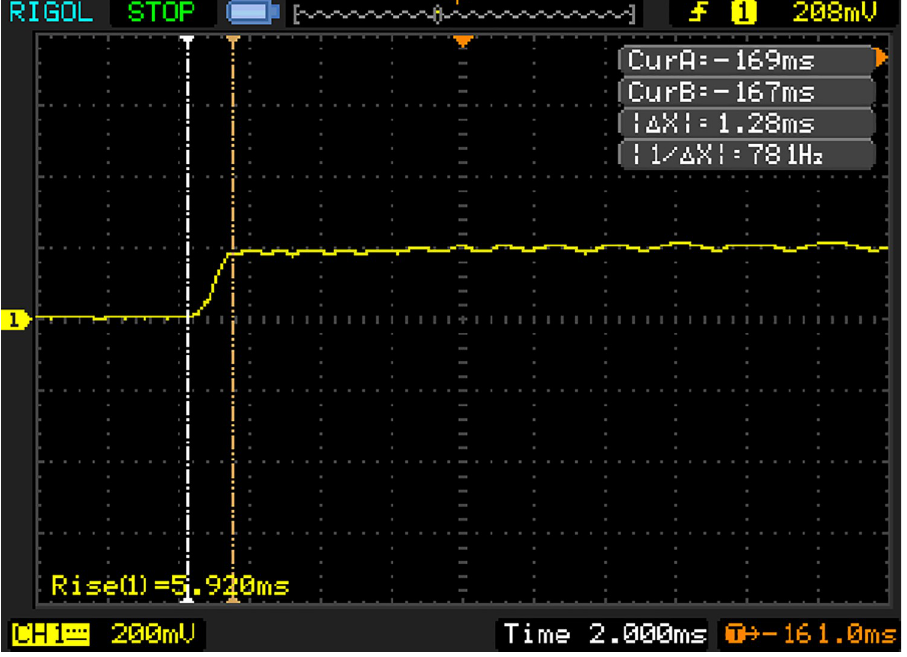
Fig 8. The dynamic response of soil moisture